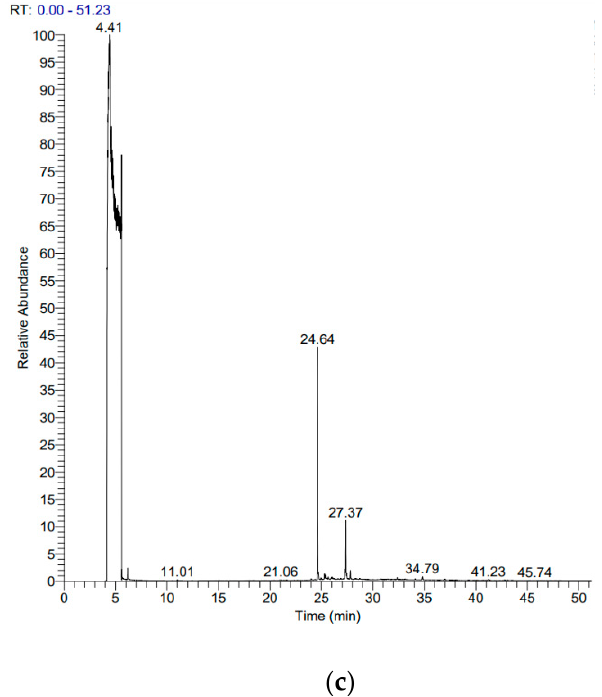
Figure 1. GC–MS chromatograms of FADE ( a ), FZDE ( b ), and FHDE ( c ) extracts. Table 4. The major expected compounds of Egyptian fresh date extracts and their structures. Various levels of polyphenols and flavanols such as nicotinic acid, p -hydroxybenzoic acid, hexadecanoic acid, protocatechuic acid, pentanoic acid, vanillic acid, gallic acid, O - coumaric acid, and caffeic acid have been identified in palm date extracts [14]. Primary and secondary metabolite profiles of 21 date varieties from Egypt were analyzed by Farag et al. [15], who reported that caffeic acid conjugates ( O -caffeoyl shikimic acid), flavonoids (quercetin and luteolin glycosides), sphingolipids, fatty acids, and flavonoids were detected as the most abundant classes amongst all the examined P. dactylifera fruit samples.